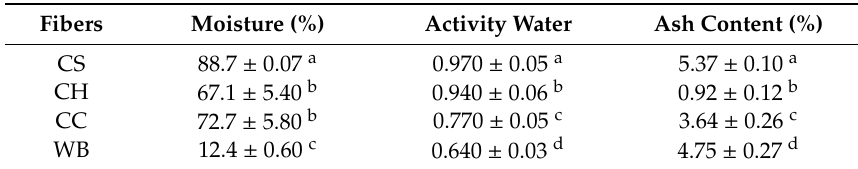
Table 2. Mean values of moisture content, water activity, and ash of lignocellulosic fibers (mean ± standard deviation).